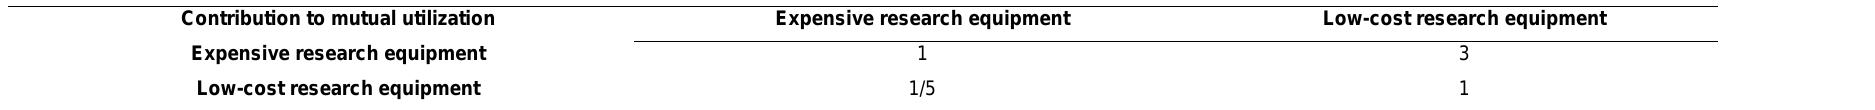
Table 9. Importance evaluation of contribution to mutual